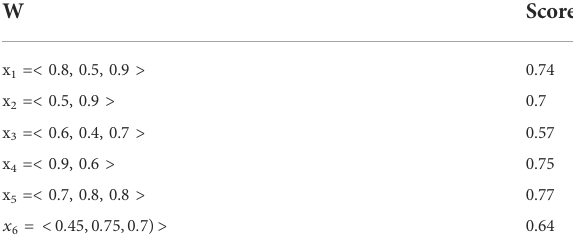
TABLE 9 HF membership of persons mental power.